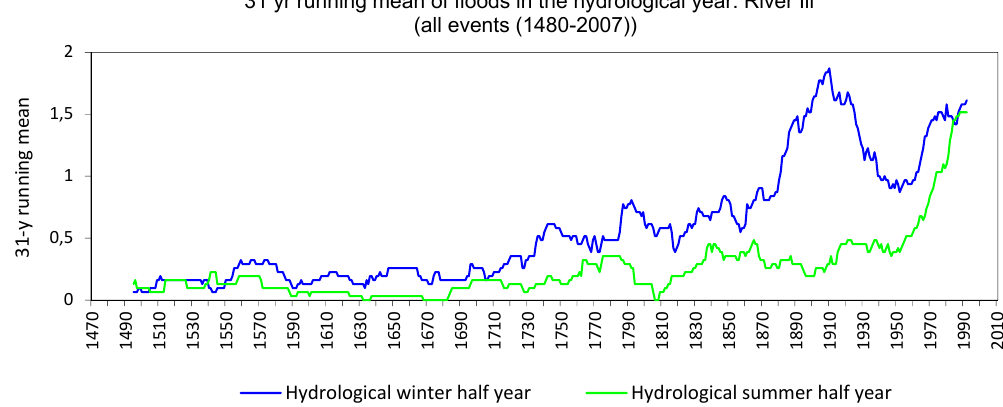
Figure 10. Floods of the River Ill (Alsace) in the hydrological summer and winter years (all events).